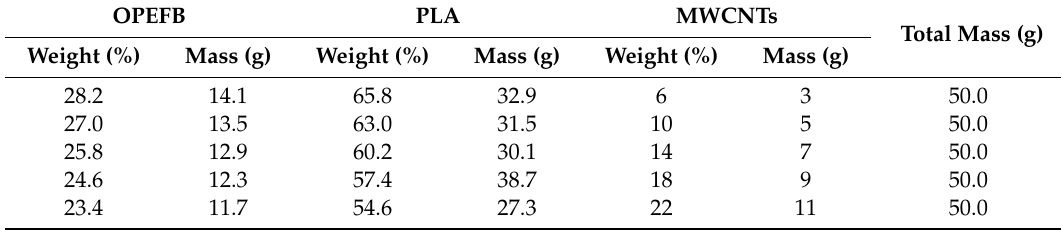
Table 1. Composition of oil palm empty fruit bunch (OPEFB) fiber / polylactic acid (PLA)-based